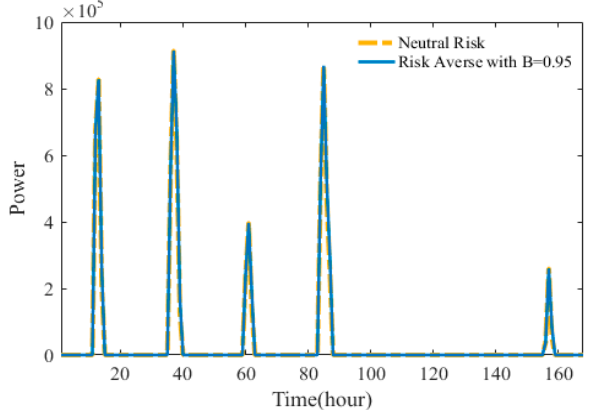
Appl. Sci. 2018 , 7 , x FOR PEER REVIEW Figure 9. Transferred power from the grid to the battery storage. Figure 9. Transferred power from the grid to the battery storage. Figure 9. Transferred power from the grid to the battery storage.